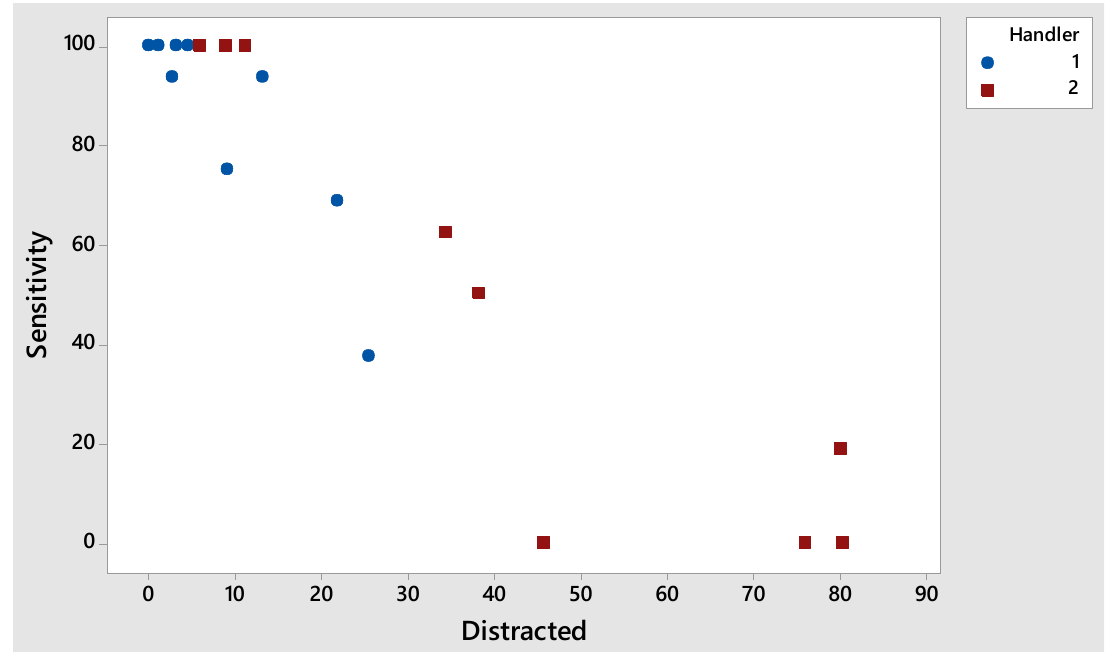
Figure 1. Strongly correlated negative relationship between the proportion of time (%) spent ‘distracted’ and the dogs’ sensitivity scores with Handler 1 and 2. The dogs’ breeds are also included. The dogs spent a significantly higher proportion of their time ‘scenting’ ( p = 0.022) with Handler 1, which significantly influenced the dogs’ sensitivity ( p < 0.001; Figure 2), PPV ( p = 0.003), and NPV ( p < 0.001) scores. Proportion of time spent ‘scenting’ was strongly correlated to the dogs’ sensitivity (Pearson correlation = 0.897; p < 0.001).